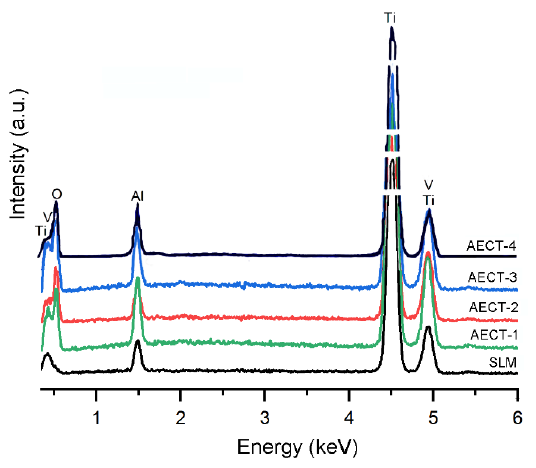
Figure 6. EDX-SEM spectra of SLM and AECT surfaces.